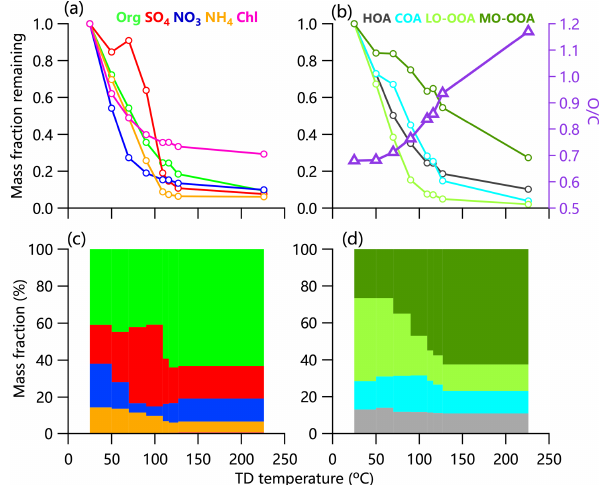
Figure 2. Thermograms of (a) non-refractory submicron aerosol (NR-PM 1 ) species, (b) OA factors, and O / C in summer 2018. Pan- els (c) and (d) show mass fractions of NR-PM 1 aerosol species and OA factors versus TD